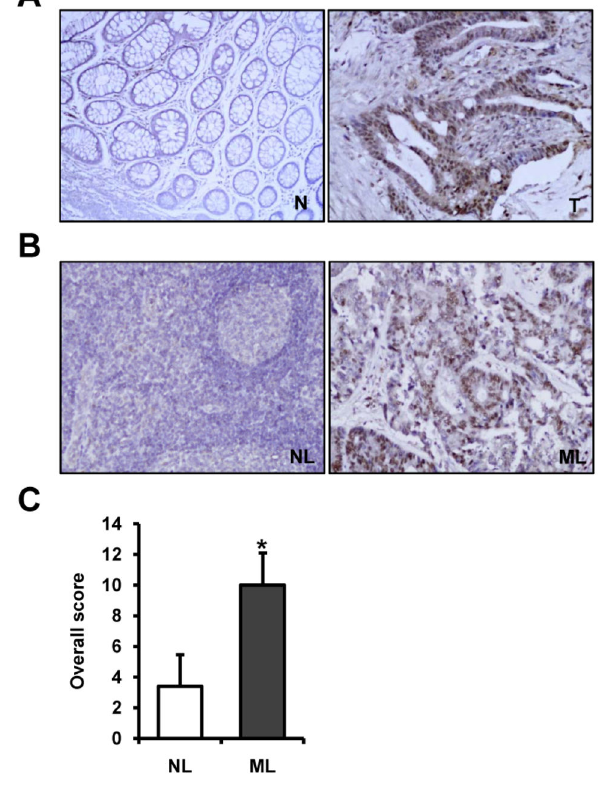
Figure 6. Livin protein expression in human colorectal cancer